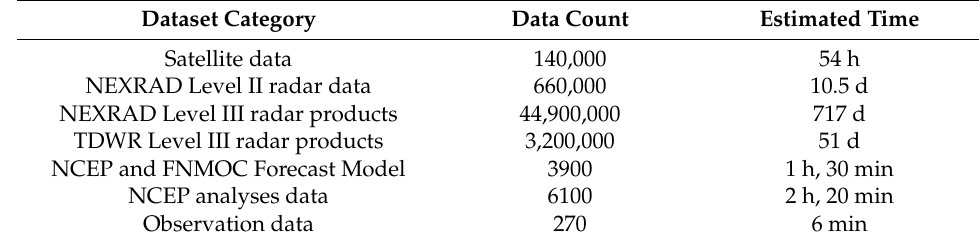
Table 4. Estimated time to register all online metadata into CSW catalogue for the Unidata IDD data.